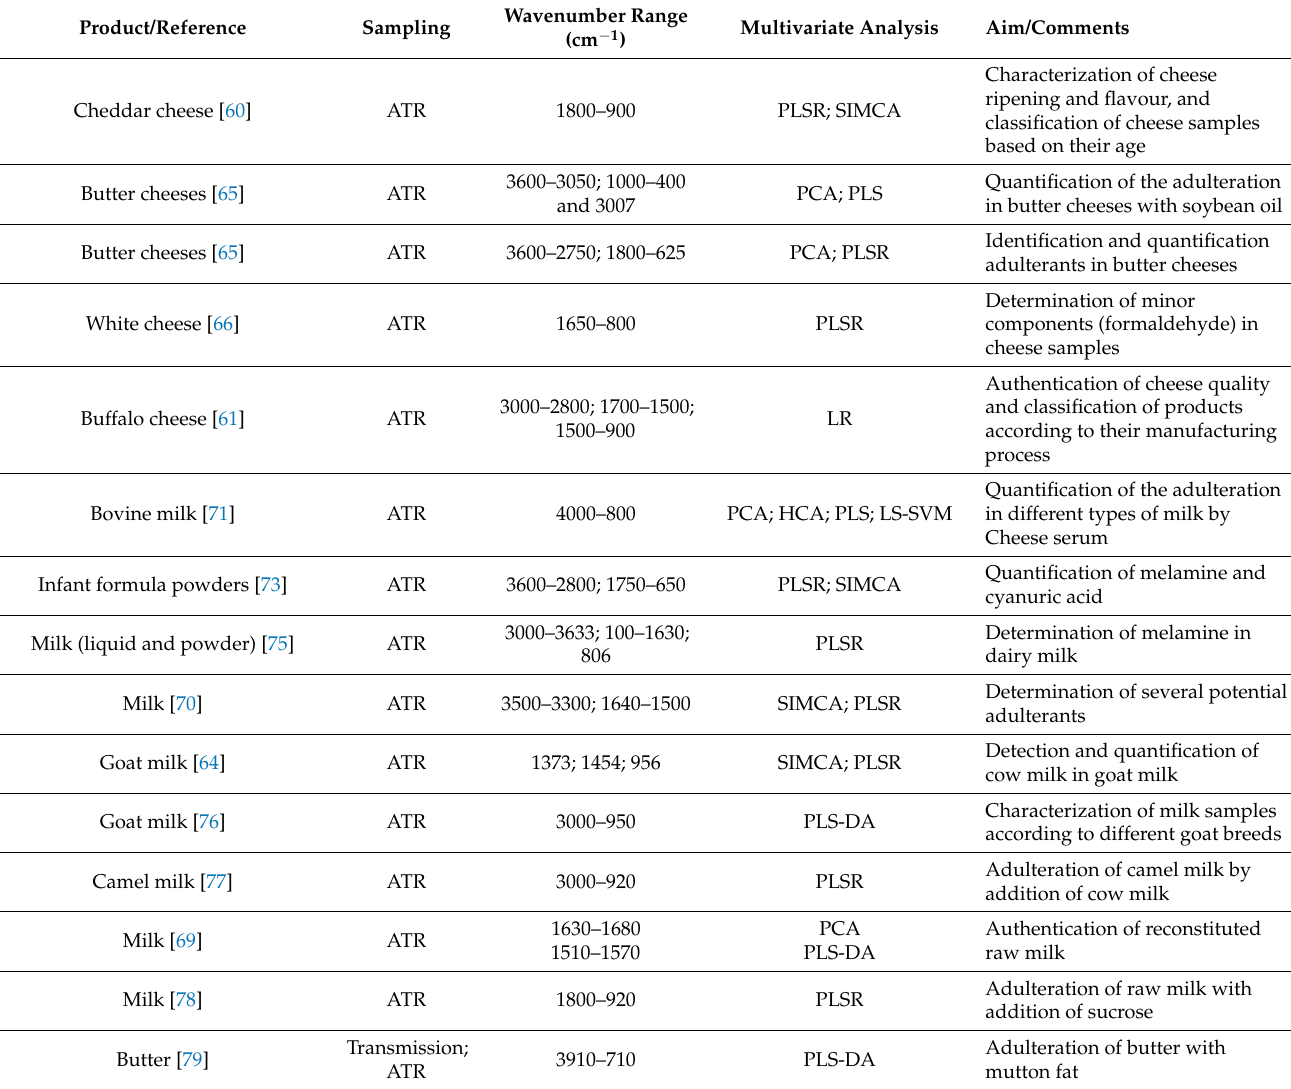
Table 2. Application of FT-MIR spectroscopy to the analysis of dairy